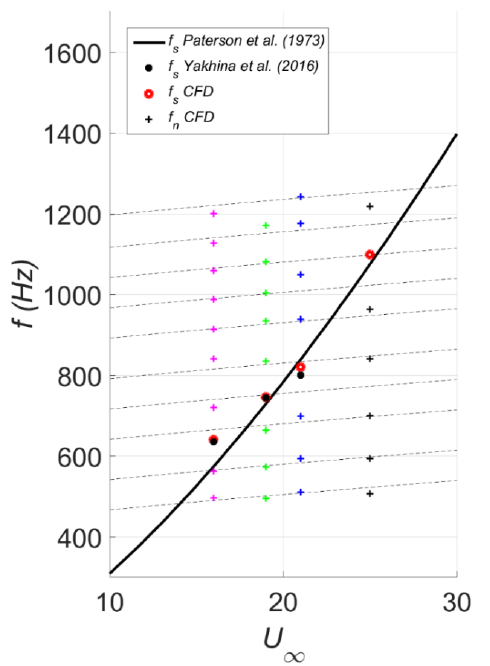
Figure 22. Frequency ladder-type structure generated from numerical simulations [18].